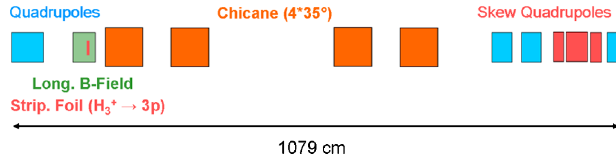
FIG. 9. Beam line from left to right for emittance transfer of a beam along the UNILAC. It comprises two quadrupole singulets, a stripping foil in between two pancake coils, a four bend chicane, a doublet, and a skew quadrupole triplet. Apertures are not to scale.